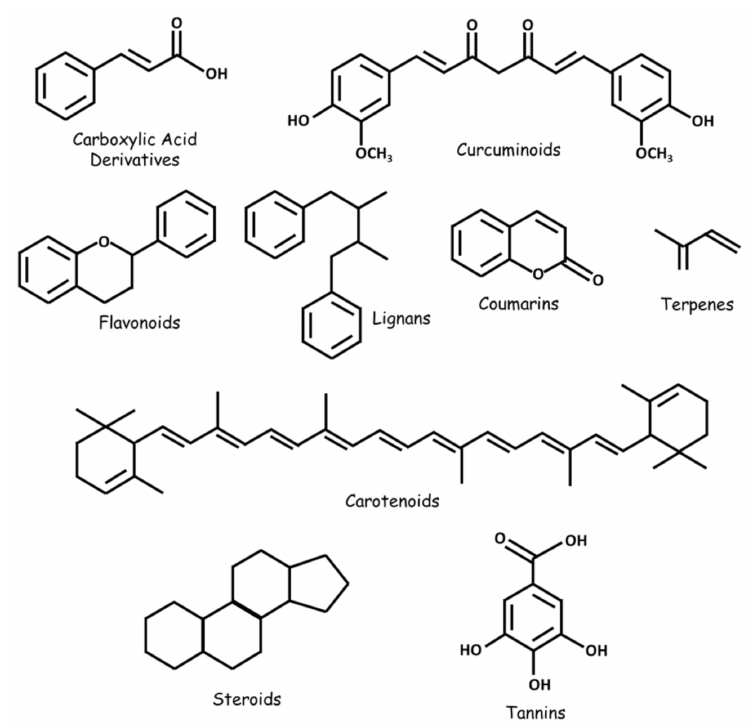
Figure 2. Some classes of natural substances with therapeutic potential in GBM.